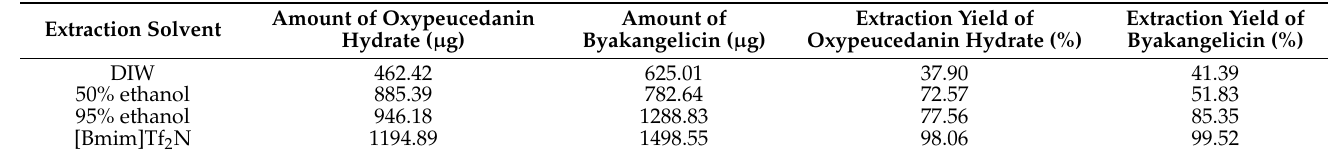
Table 8. Comparison of the extraction ability of different solvents.